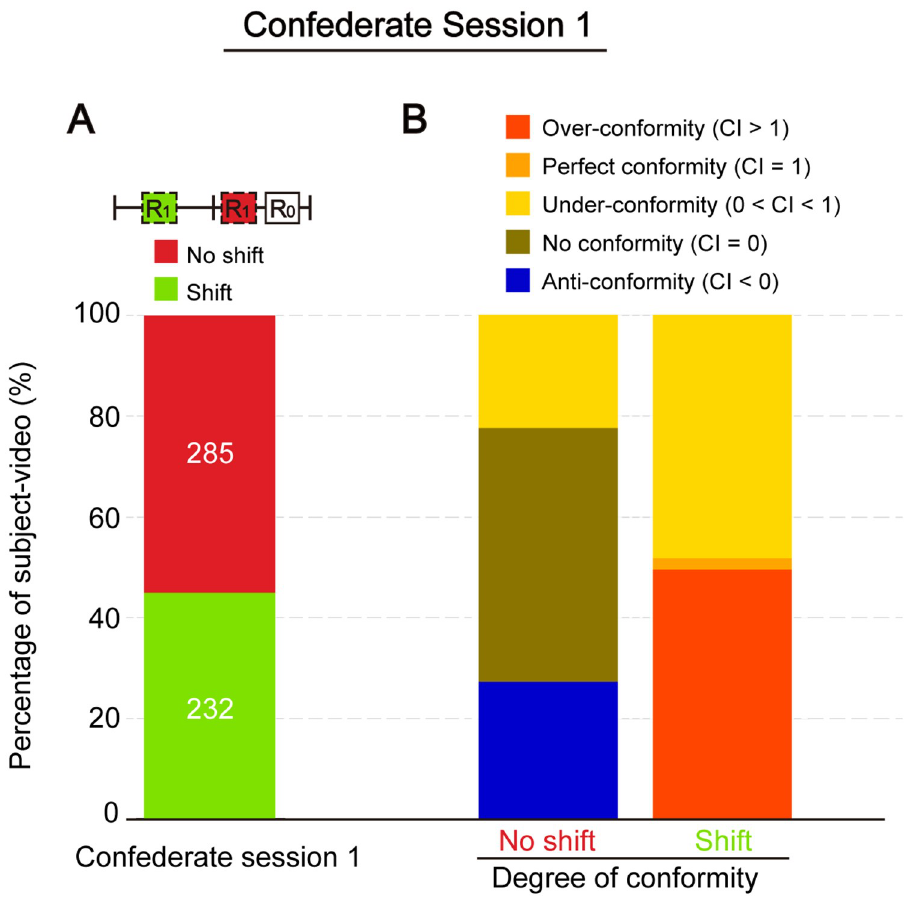
Fig 2. Different conforming behaviours to an opposite-sided confederate in session 1. (A) Percentage of subject- videos who shifted and did not shift side after being shown the first confederate value (C 1 ) that was on the opposite side of their initial response (R 0 ). Number of datapoints is indicated on the bars (n = 517). (B) The no-shift and shift group in (A) further classified by the degree of conformity based on participants’ conformity index (CI).